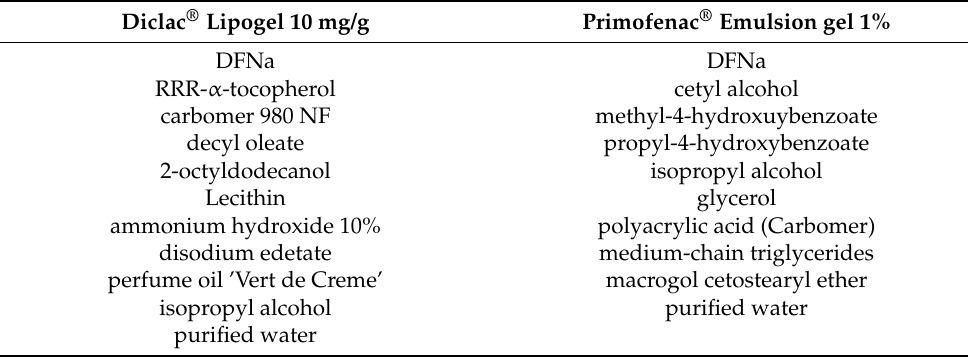
Table 1. Ingredients of the topical formulations, Diclac ® and Primofenac ®